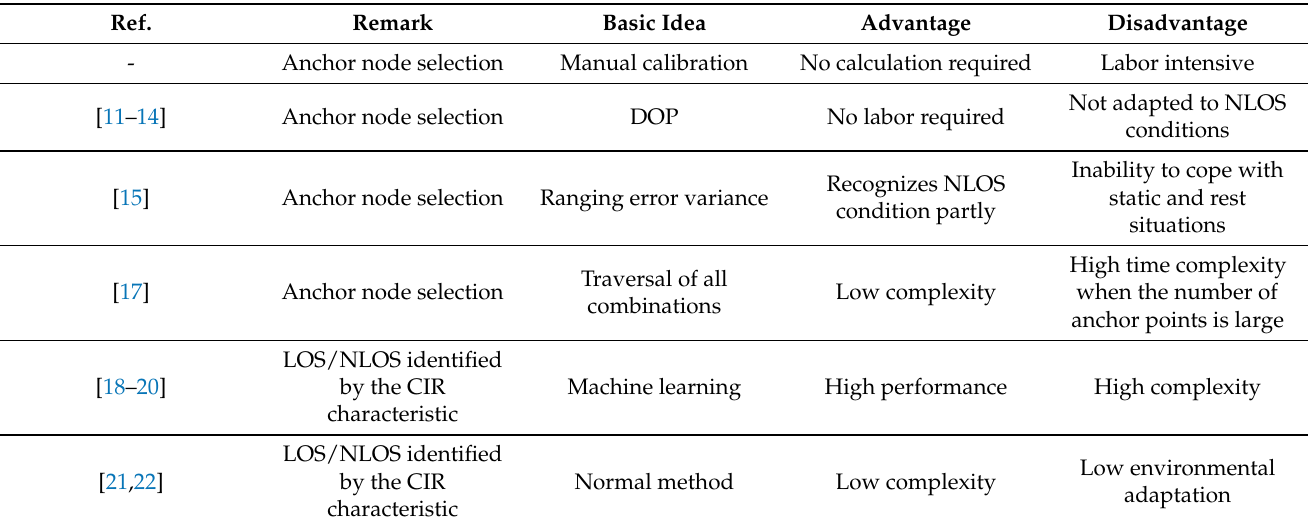
Table 1. Summary of the related